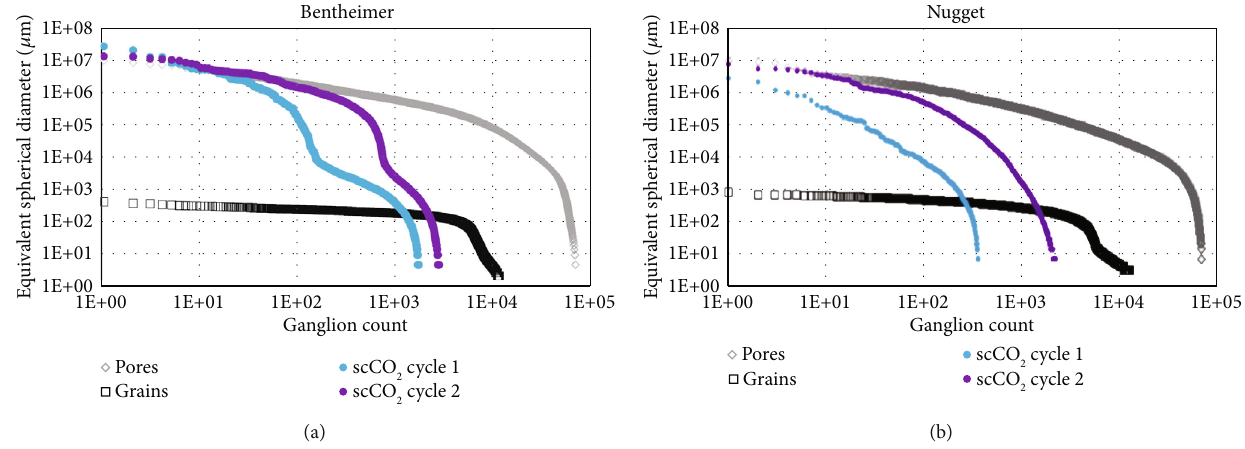
Figure 4: Pore, grain, and scCO